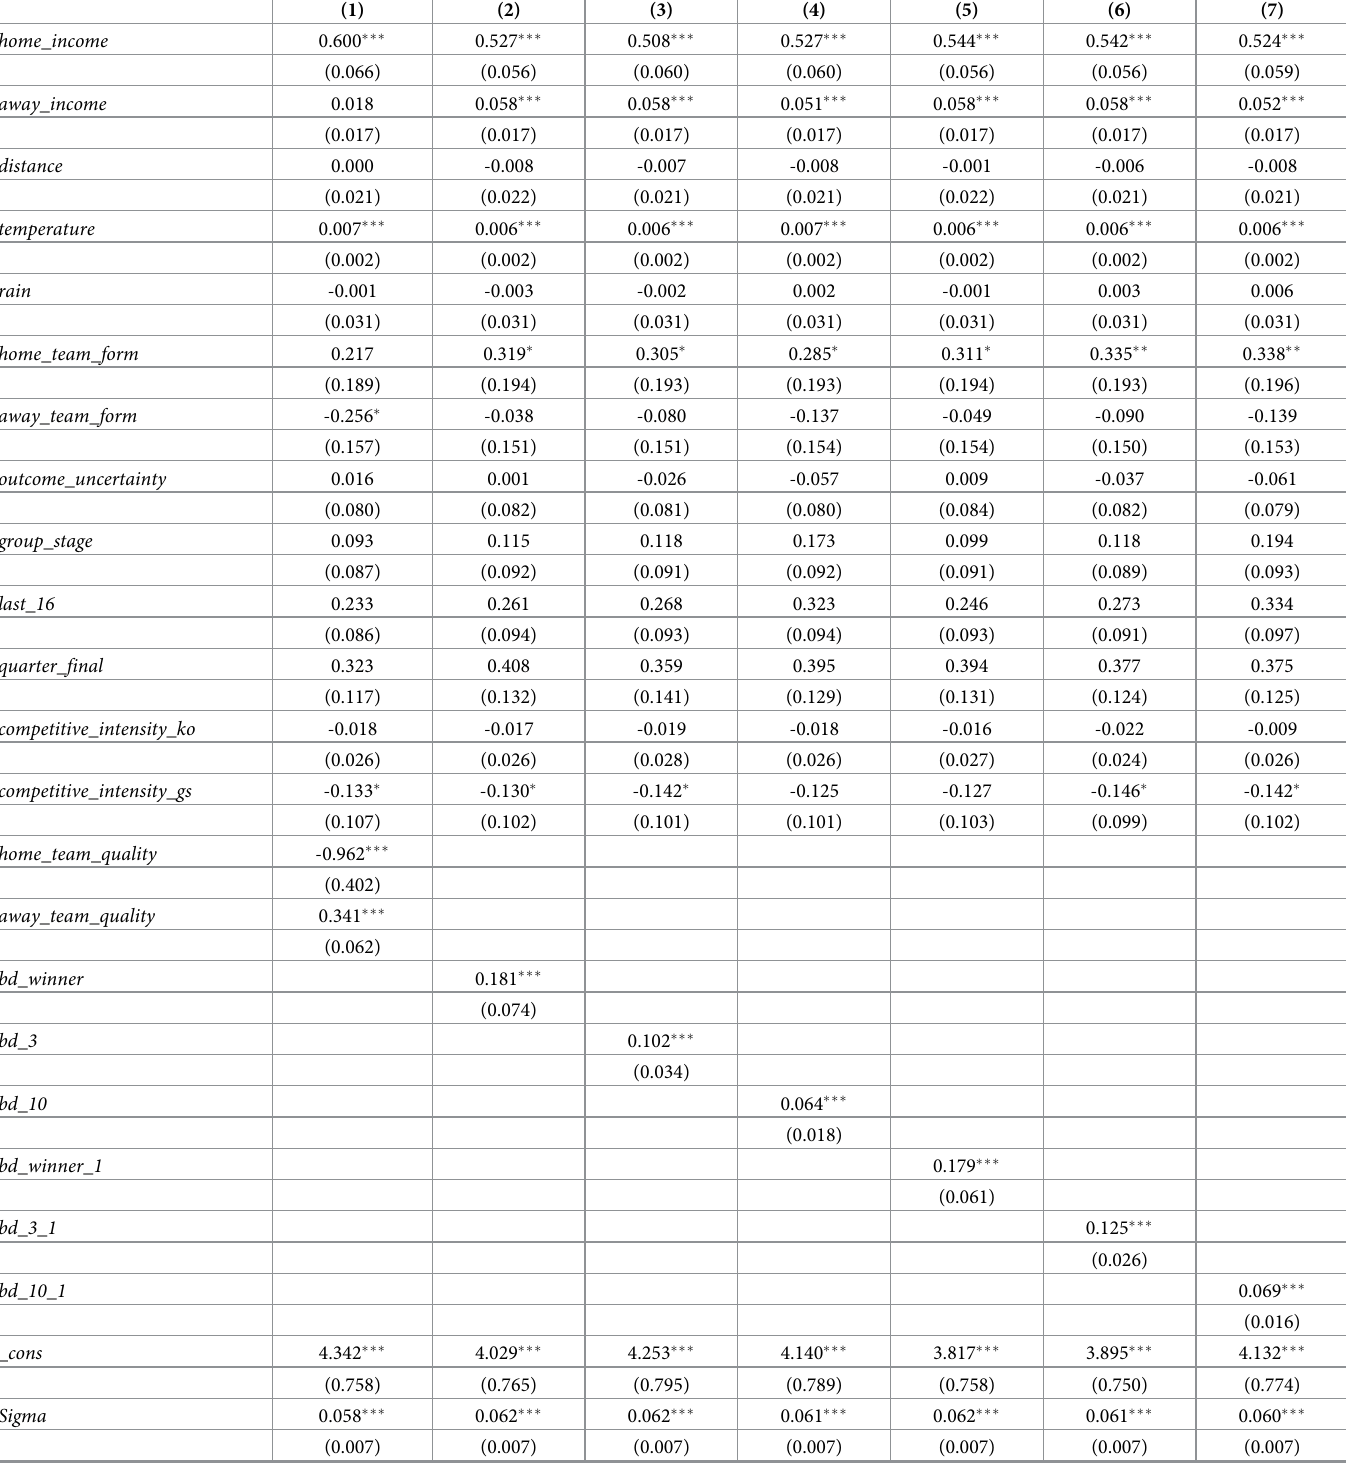
Table 4. UCL attendance in the other